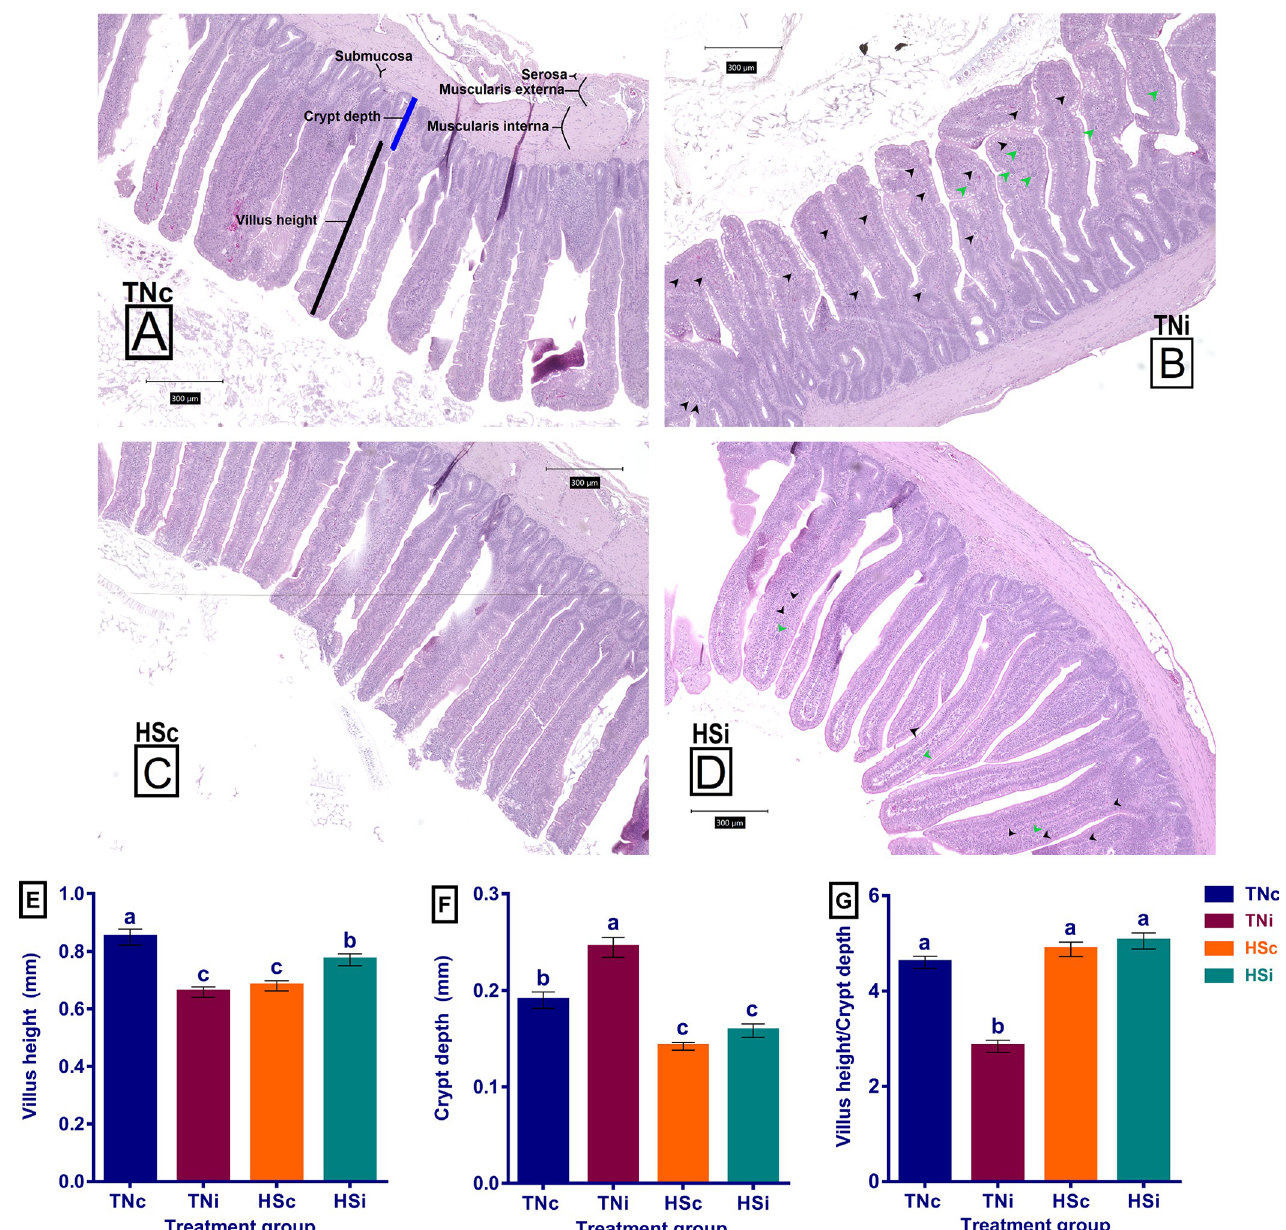
Fig 8. The ileal histopathology and morphological parameters. The histopathology picture: Photomicrograph of ileum tissue stained with hematoxylin and eosin (H&E), at 100x magnification, of TNc (A), TNi (B), HSc (C), and HSi (D); the villus height (E); the crypt depth (F); the villus height to crypt depth ratio (G); at 6 dpi of chickens infected with E . maxima and their uninfected controls that are raised in thermoneutral or heat stress environment: TNc = thermoneutral control, TNi = thermoneutral infected, HSc = heat stress control, HSi = heat stress infected. Significant differences (p < 0.05) were depicted by different letters. The error bars represent the SEM. The ileum histological components were illustrated (A). The arrow heads point the E . maxima stages (B, D) gametocytes (black arrow heads) and schizonts (green arrowheads).